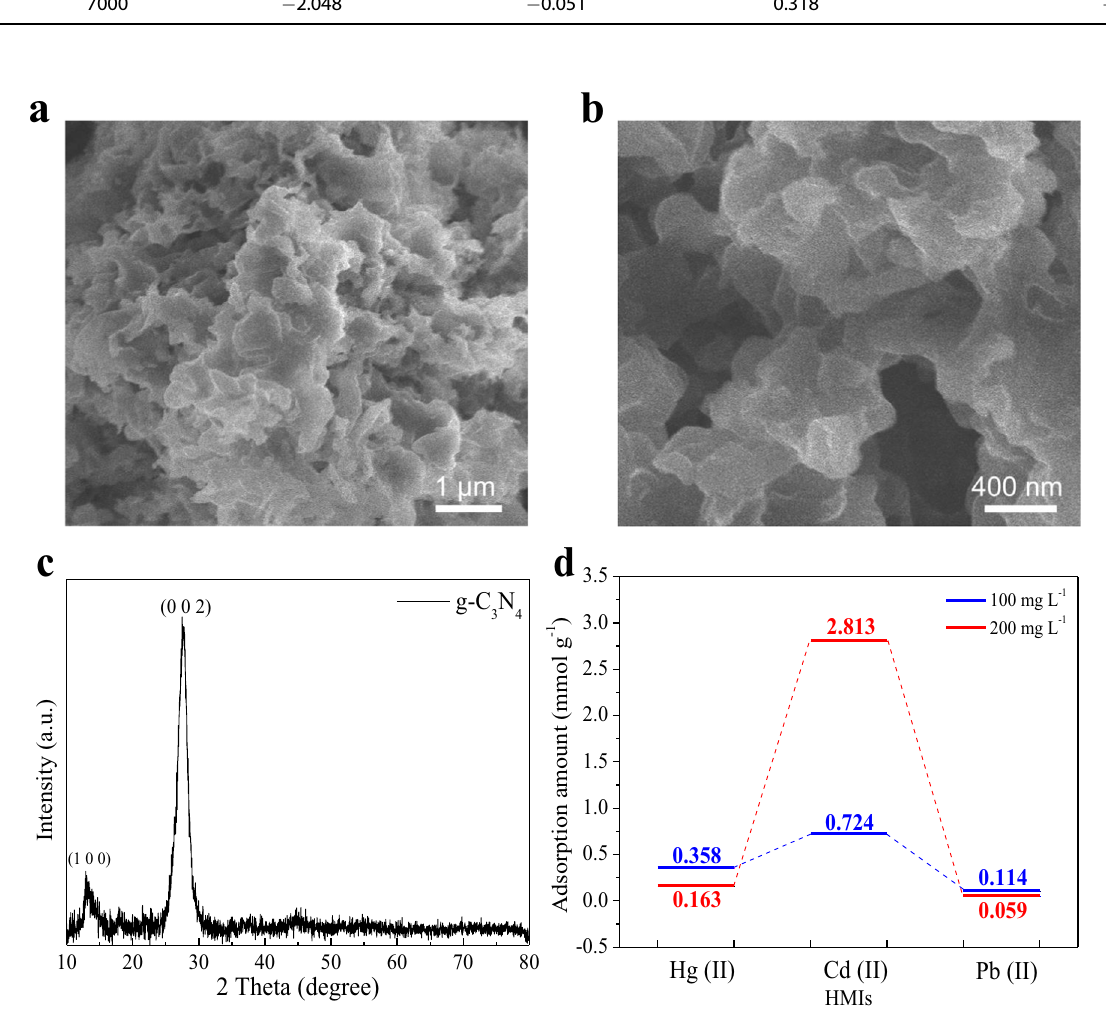
Fig. 6 Experimental veri fi cation. a , b SEM images of g-C 3 N 4 and c corresponding XRD pattern. d The adsorption ability towards three HMIs in two initial